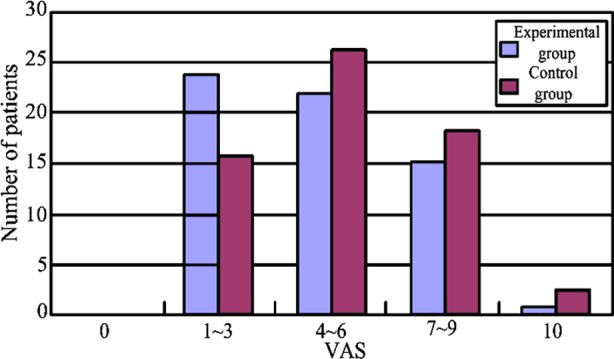
Number of cases with different grade of VAS 48 h after surgery.